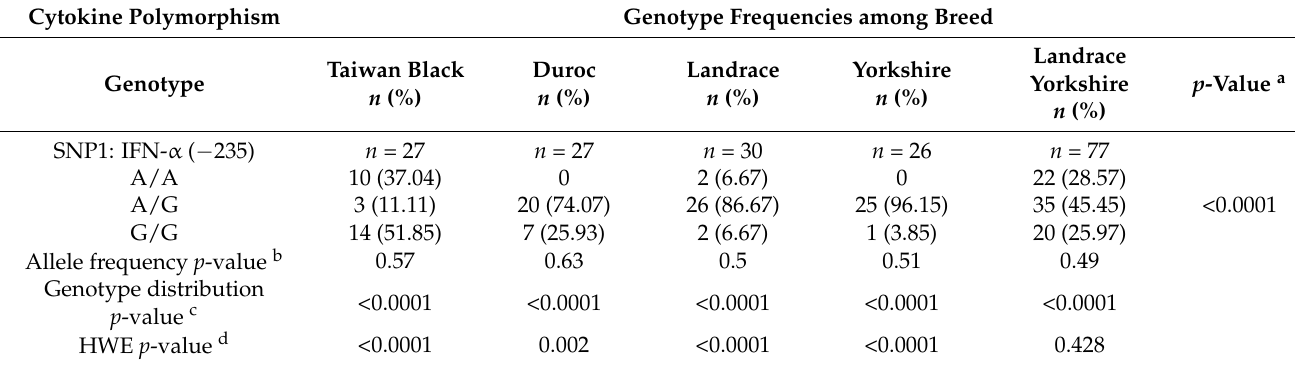
Table 2. The genotype distribution of SNPs in cytokine genes and their association with different pig breeds. Cytokine